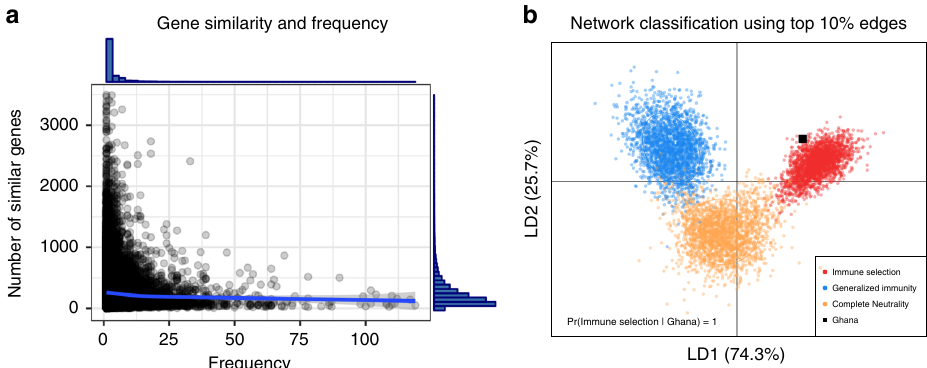
Fig. 5 Empirical investigation of the Ghana data shows resemblance to the immune selection scenario. a Negative correlation between DBL α type frequencies and their number of similar genes for the upsB/upsC var genes in the parasite population ( r = − 0.040, p < 2.2e – 16). The number of similar genes is calculated as the degree ( k ) of a focal gene in the gene similarity network, for amino acid similarities above 0.6. Histograms on the top and right of the plot show the distributions of k and DBL α -type frequencies, respectively. b Classi fi cation of networks generated with the agent-based model using Discriminant Analyses of Principle Components 66 onto a 2-D space formed by the two linear discriminant (LD) functions using the top 10% edge weights. The empirical network is more likely to be generated under an immune selection regime (posterior probability [PP] = 1), as opposed to neutrality (PP = 3.57E – 8) or generalized immunity (PP = 2.15E – 9). The classi fi cation relies on comparisons of 34 network properties (see Supplementary Table 1) trained with 7000 simulated networks and veri fi ed on test sets of 800 networks (i.e., 100 combinations of different parameter settings for each of the scenarios were run; infected hosts were sampled in October and the next June each year, as for the empirical sampling, at the stationary stage of the simulations (i.e., the last 26 years in the simulations); similarity networks were then built for randomly sampled parasites from the sampled hosts). Accuracy of network classi fi cations is above 0.99 for each scenario (see Supplementary Table 2 for comparisons of accuracy and the classi fi cations of the empirical network using different percentage of top edges in the network, and Supplementary Fig. 5 for motif properties of the empirical network compared with simulated